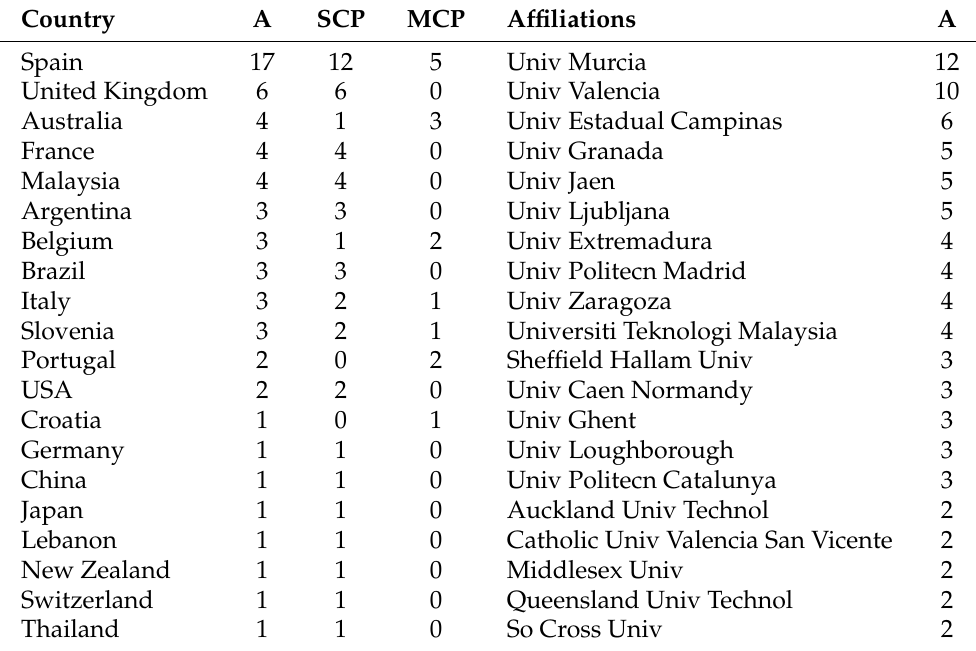
Table 6. 20 Corresponding author’s country (SCP: single country publications, MCP: multiple country publications) and 20 Most Relevant